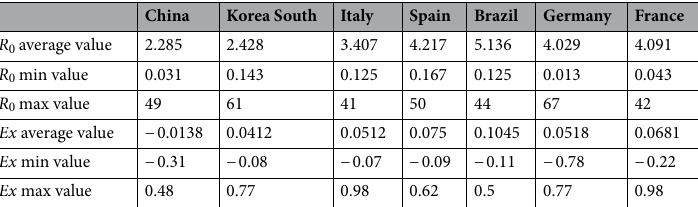
Table 4. The measurement of the reproduction number and the exponential growth rate according to TW-SIR model.